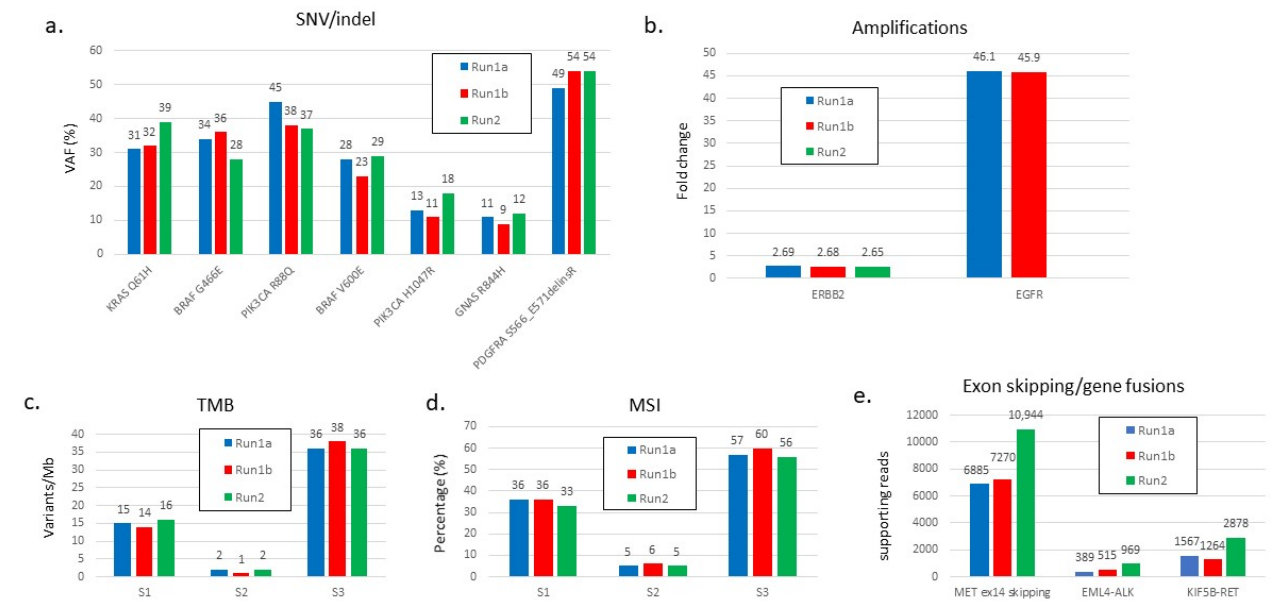
Figure 1. Repeatability and reproducibility of the TSO500 assay for the different types of variants and biomarkers. ( a ) SNVs and indels, ( b ) amplifications, ( c ) TMB, ( d ) MSI, and ( e ) exon skipping and gene fusions events. Three samples were analyzed in the same run (intrarun), indicated as Run1a (blue bars) and Run1b (red bars), as well as in another run (interrun), indicated as Run2 (green bars).